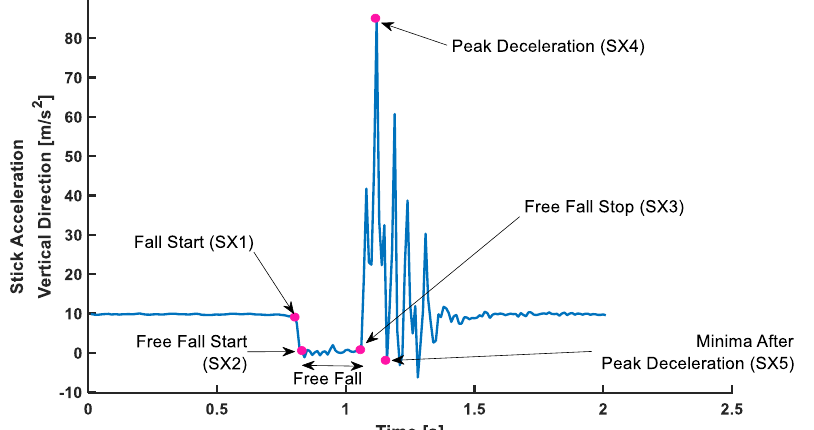
Figure 5. Five Stick fall events: (i) Fall start (SX1), (ii) Free Fall Start (SX2), (iii) Free Fall Stop (SX3), (iv) Peak Deceleration (SX4), (v) Minima after Peak Deceleration